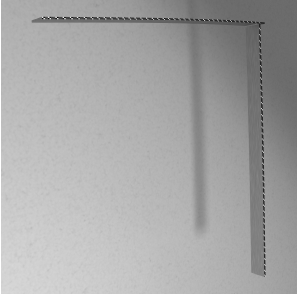
Figure 13. Rendered image of the L-shape crane structure under